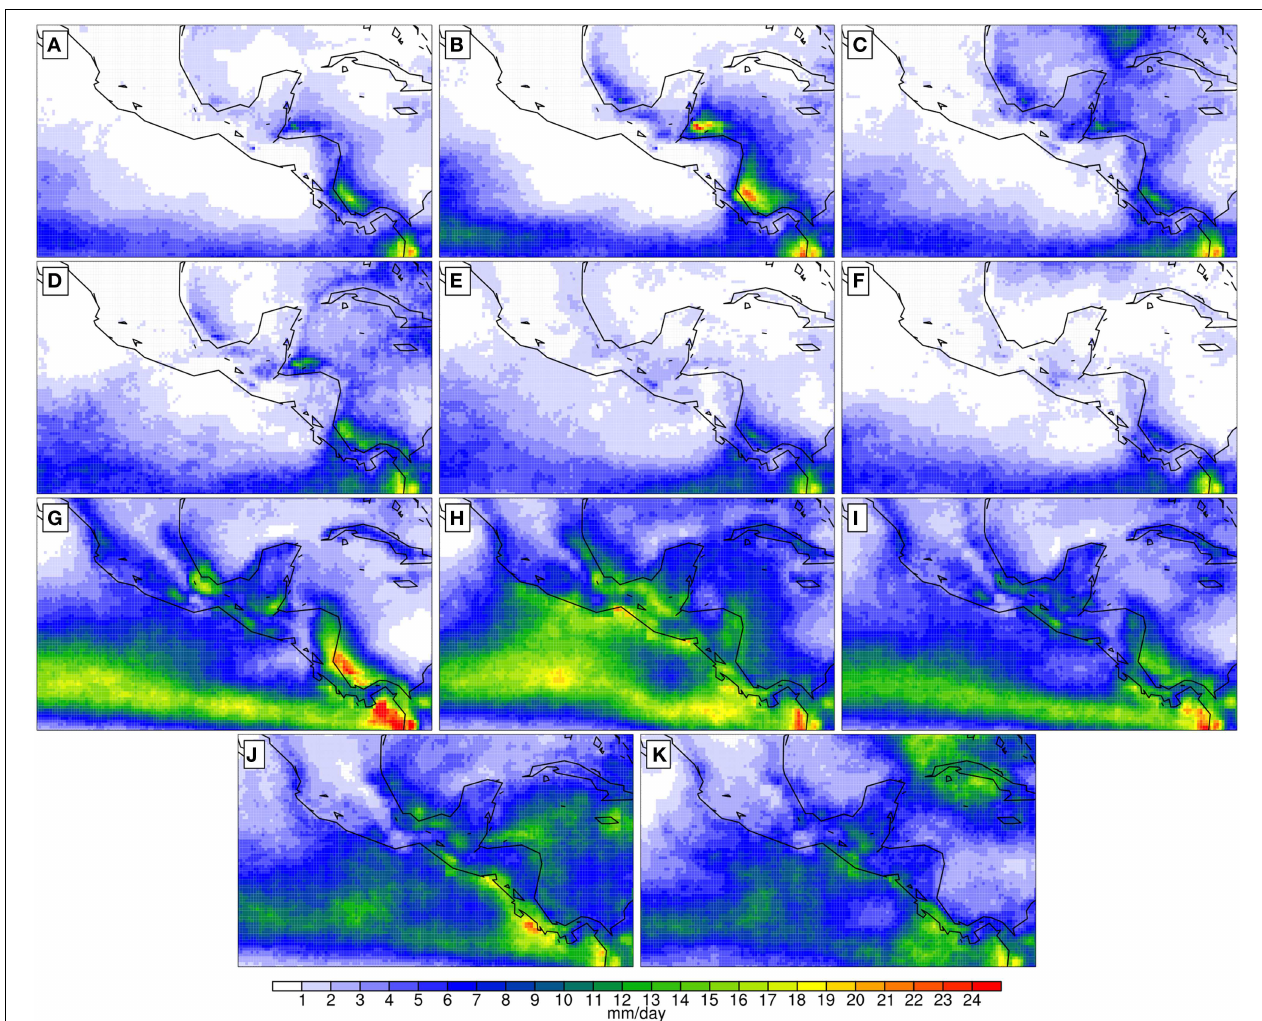
FIGURE 9 | Composited TRMM 3B42 precipitation fields [mm/day] for (A) WNEW, (B) WNCS, (C) WGCS, (D) WNWS, (E) SPAG, (F) SPNW, (G) SLLJ, (H) SMWR, (I) ASWW, (J) AGAD, and (K) ENAH regimes.